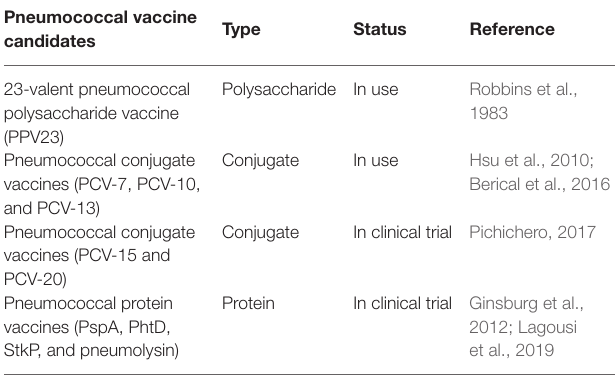
TABLE 2 | Summary of different pneumococcal vaccine